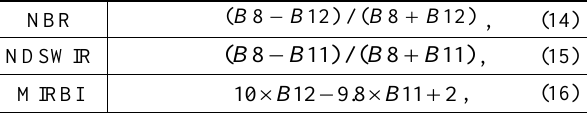
Table 3. Popular sentinel-2 burnt detection spectral indices.